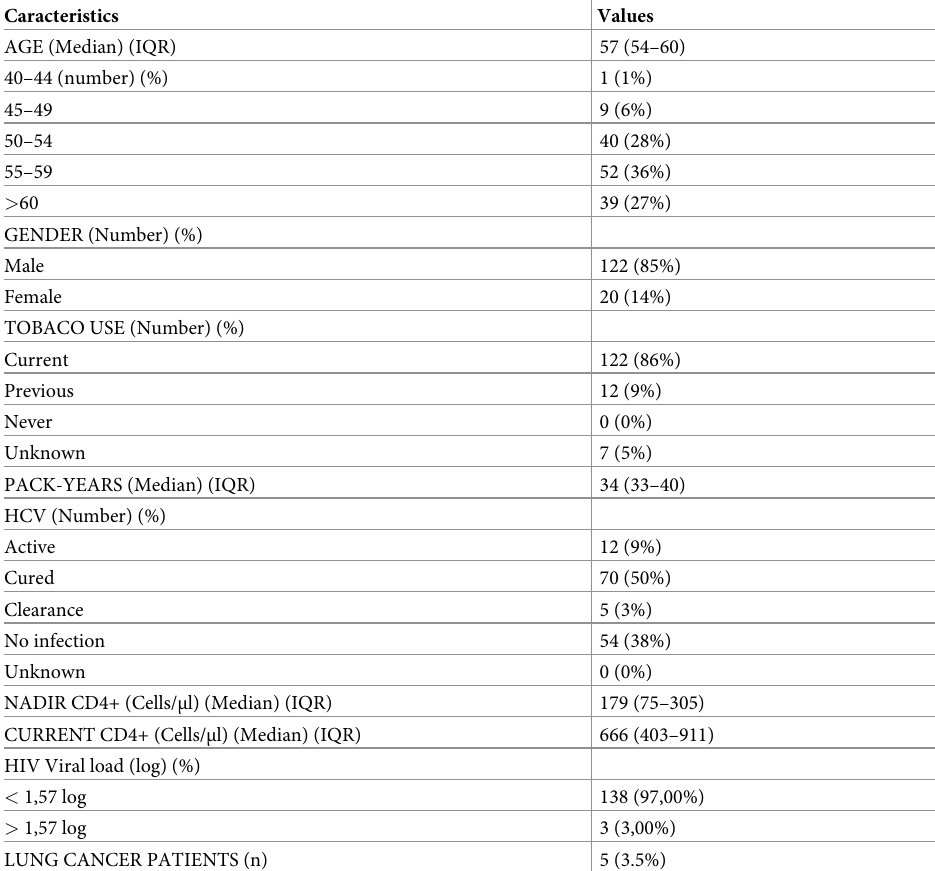
Table 1. Patient baseline